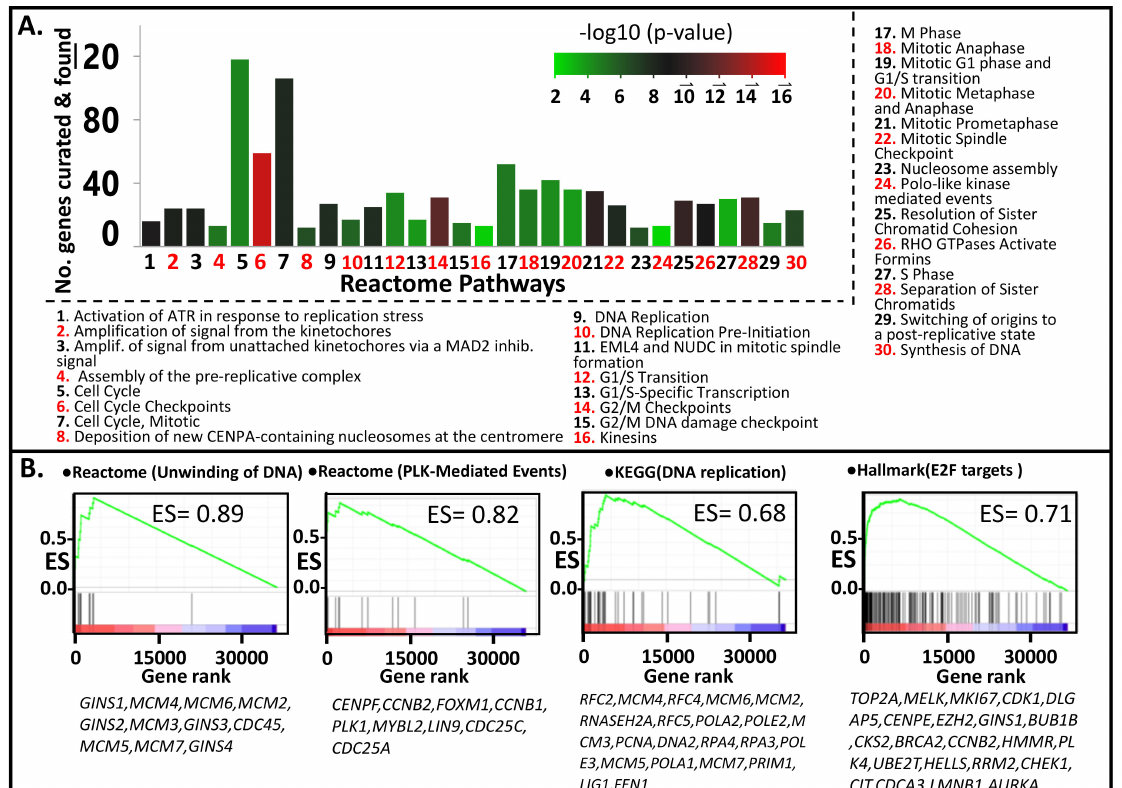
Figure 2. Pathways that are more enriched in metastatic relative primary tumors, identified through ( A ) Reactome analysis with the top 500 upregulated genes (metastasis vs. primary tumors), were used as input. ( B ) GSEA analysis. Shown are the GSEA plots for the pathways exhibiting the highest Enrichment Scores (ES) among the Reactome, KEGG, and Hallmark Gene Sets.